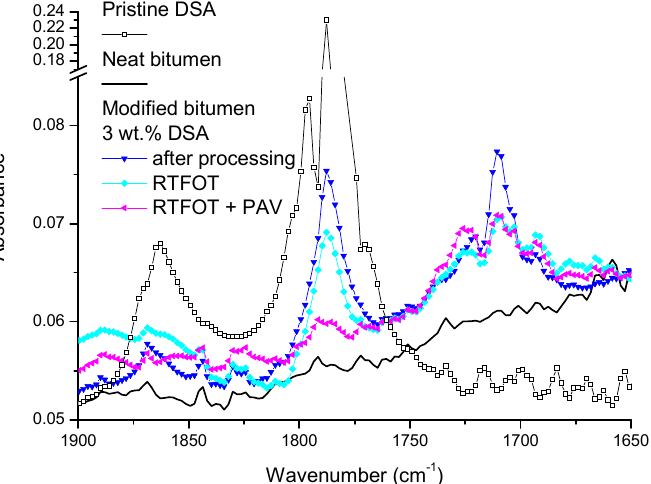
Figure 11. FTIR spectra for pristine DSA, neat bitumen and DSA modified bitumen after processing and after ageing by RTOFT and by RTOFT + PAV.